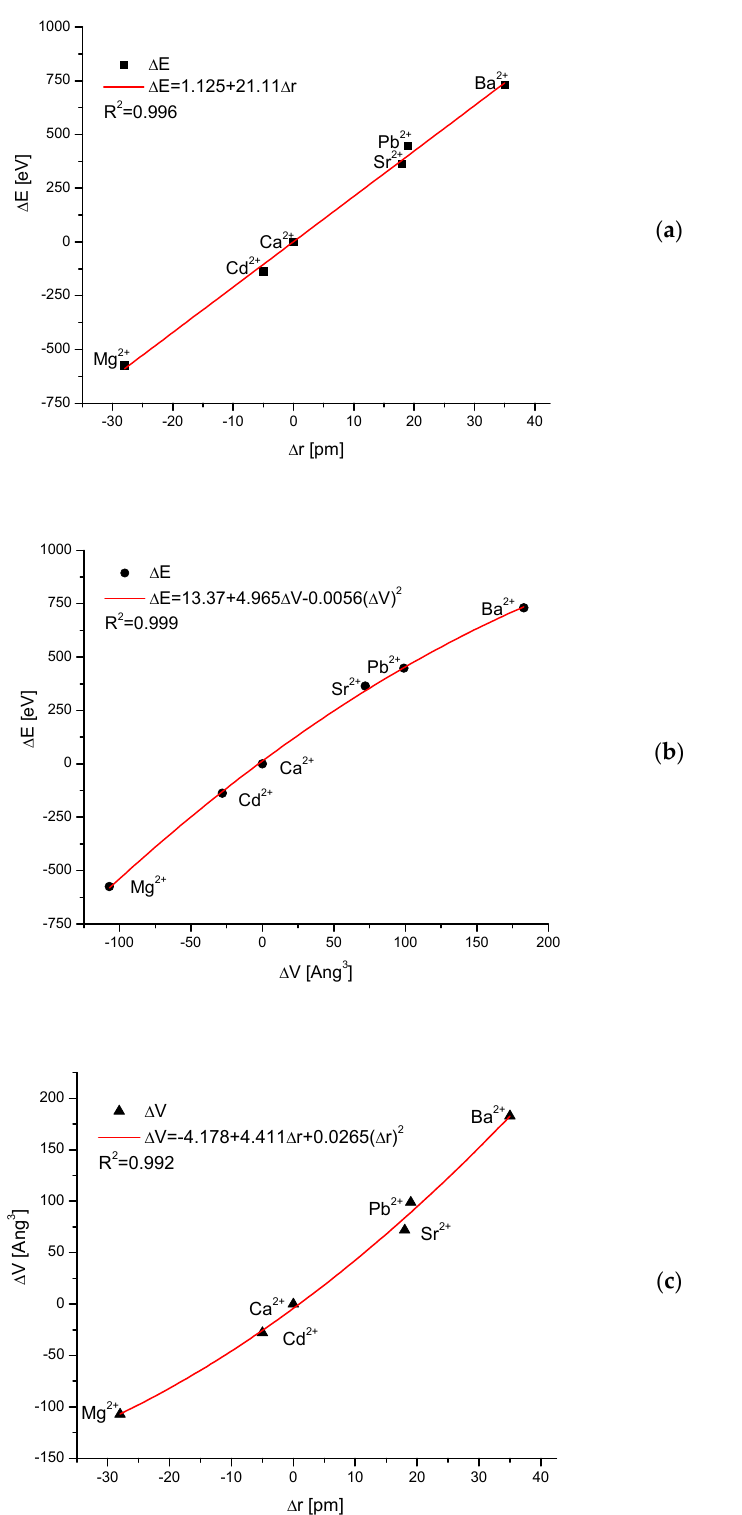
Figure 4. Relationship between the energy changes and the kind of introduced ions as a result of cationic substitutions in apatites; ( a ) the dependence on the difference in ionic radius of introduced ions; ( b ) on the difference in crystallographic cell volume. ( c ) The proportionality between growth of ionic radius of introduced ion and growth of crystallographic cell